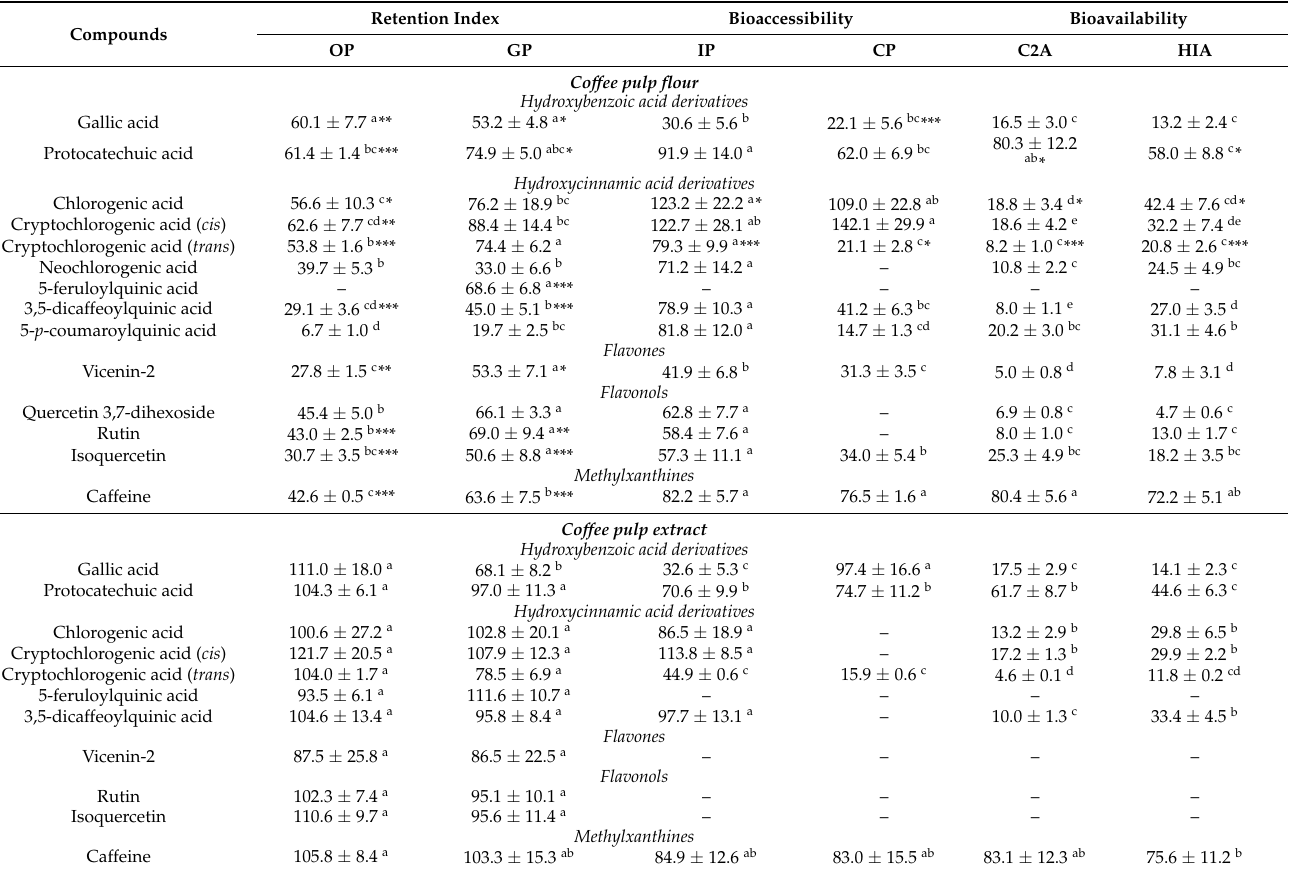
Table 3. Retention index, bioaccessibility, and potential bioavailability (%) of individual phenolic compounds and methylxanthines from the coffee pulp flour (CPF) and extract (CPE) throughout simulated gastrointestinal